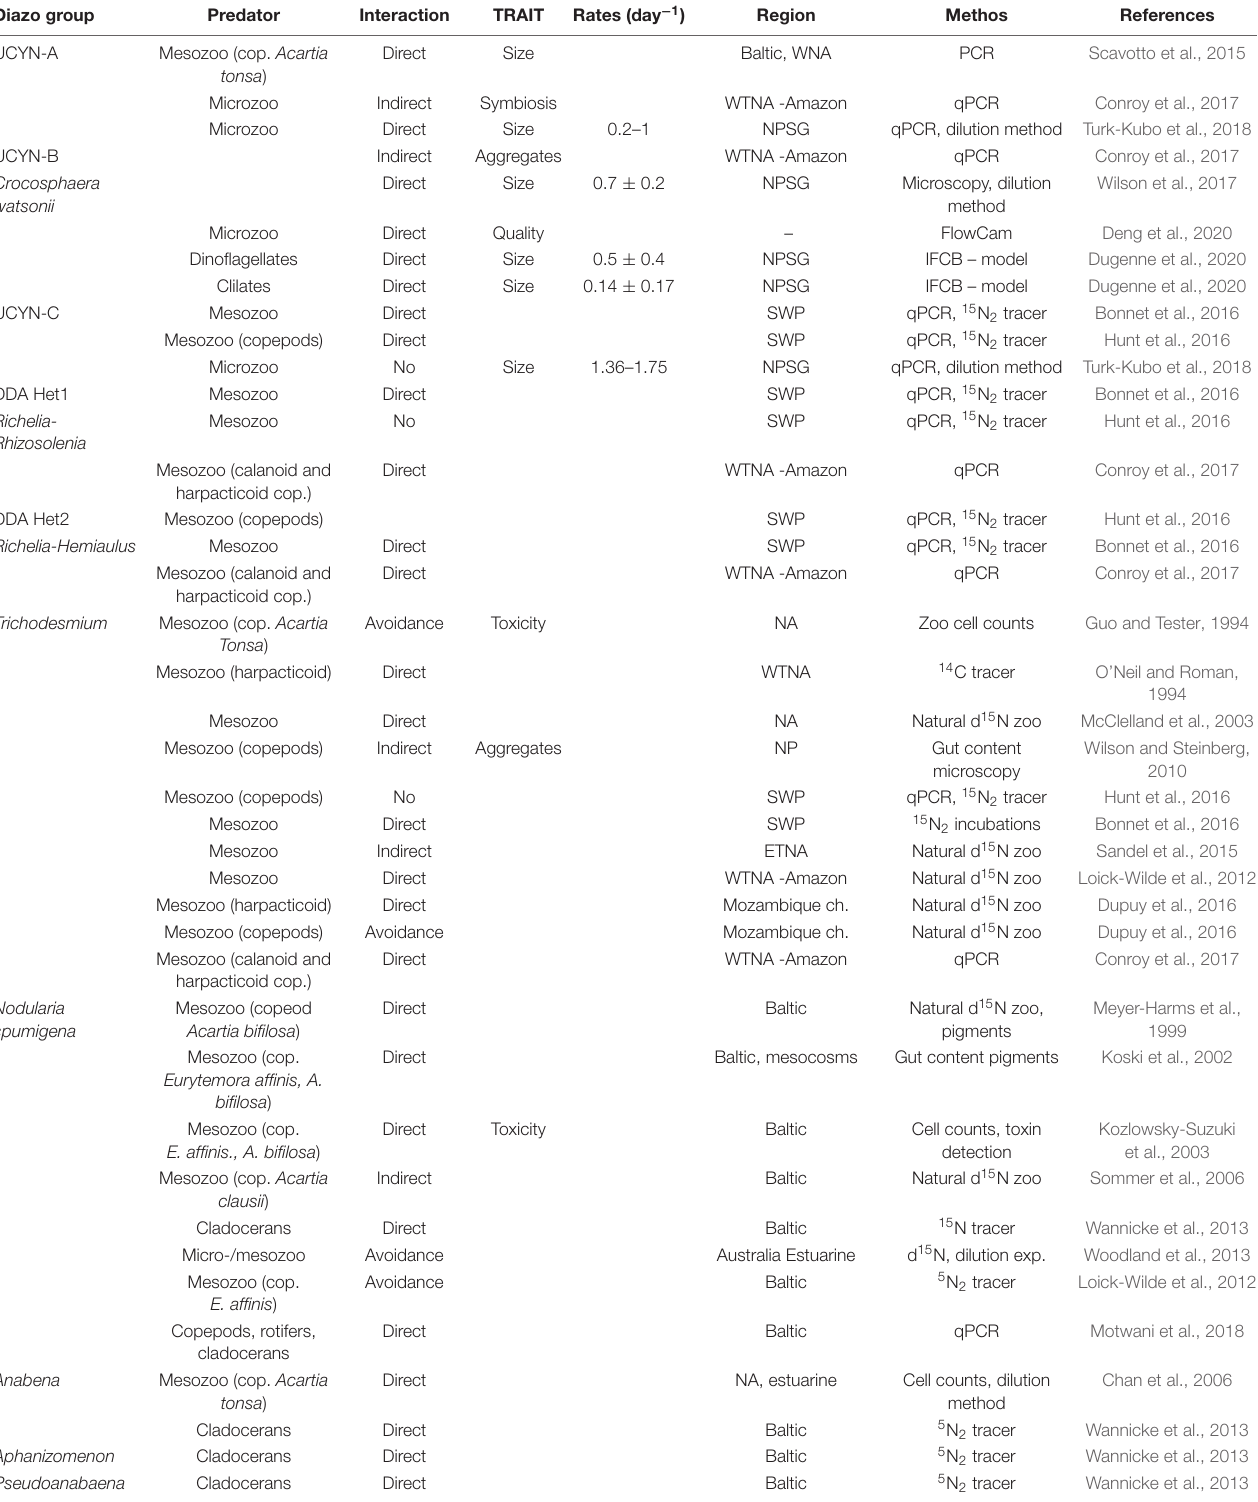
TABLE 1 | Literature reporting grazing on